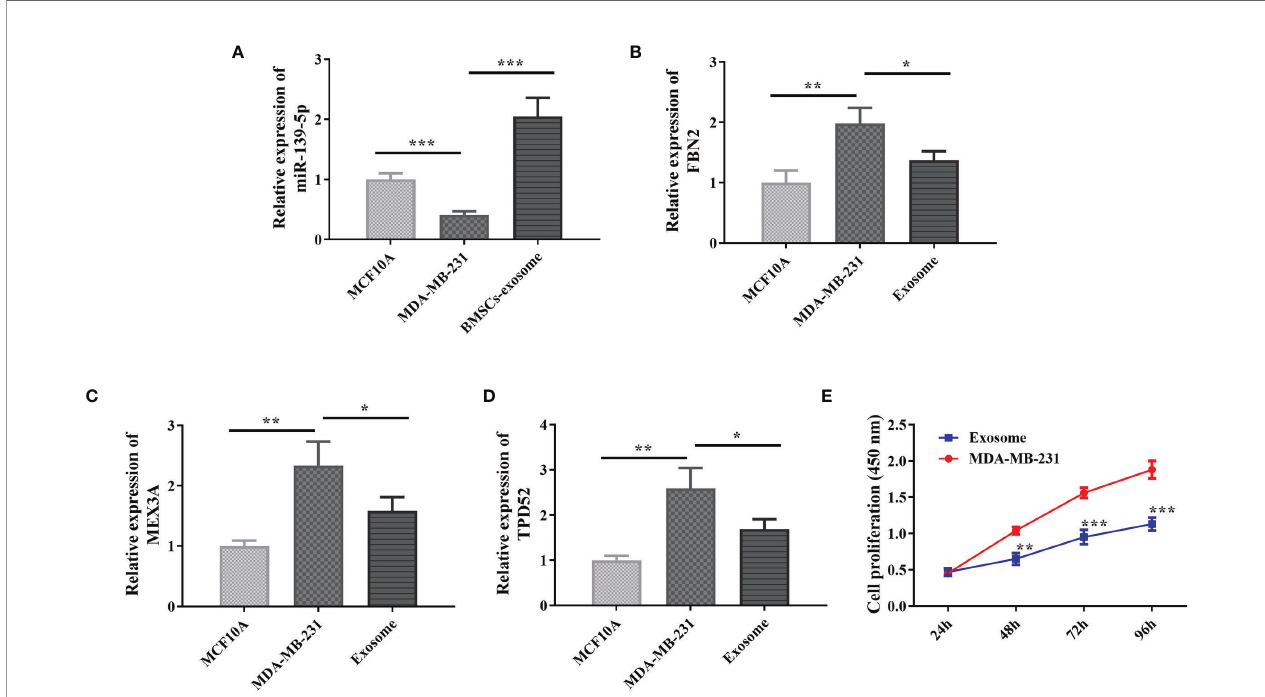
FIGURE 8 | Expression of miR-139-5p and its target genes in cells and effect on proliferation. (A) Expression of miR-139-5p in cells; (B) Expression of FBN2 in cells; (C) Expression of MEX3A in cells; (D) Expression of TPD52 in cells; (E) Effect of BMSCs exosomes on cell proliferation, compared with control, * P < 0.05, ** P < 0.01, *** P <